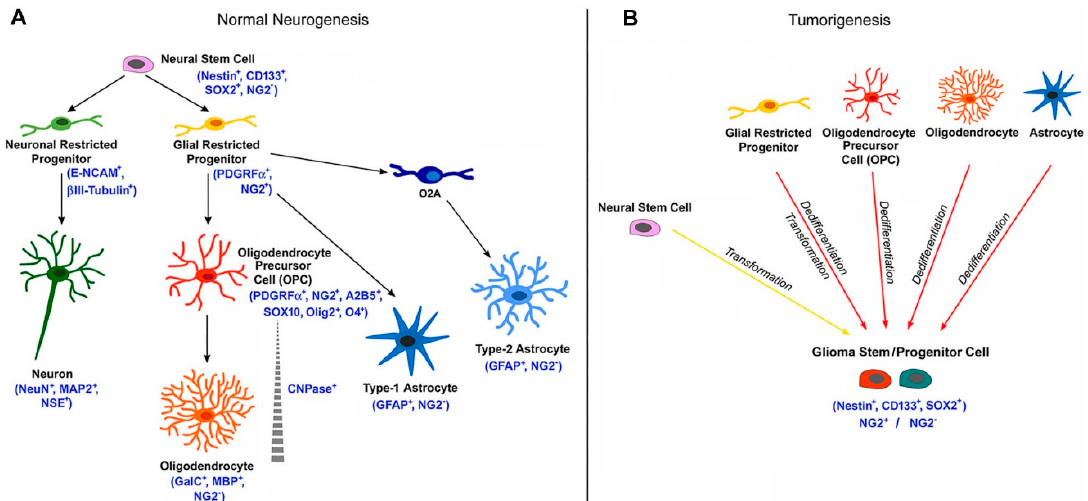
Figure 3. Scheme of the NG2/CSPG4 expression in the nervous cytogenesis and gliomagenesis. ( A ) Scheme representing the expression of NG2 marker during normal neurogenesis and the different cell fates of NG2-glia. Canonically, NG2-glia (NG2+ glial restricted progenitors) have the capability to proliferate and differentiate into oligodendrocyte precursor cells (OPCs) giving, then, rise to oligodendrocytes in the immature and mature brain. However, NG2-glia can also differentiate into astrocytes. Additionally, in vitro, NG2-glia can differentiate into type-2 astrocytes through the O2A progenitor cells. ( B ) NG2+ cells can also be considered as potential cells for the origin of malignant glioma. During tumorigenesis, the glioma stem cell is believed to derive from transformation of neural stem cell or from dedifferentiation and transformation of NG2+ glial restricted progenitors, OPCs, or mature cells (astrocytes and oligodendrocytes). The arising tumor cells show potential for self-renewal, and express markers associated with both stem and progenitor cell types.